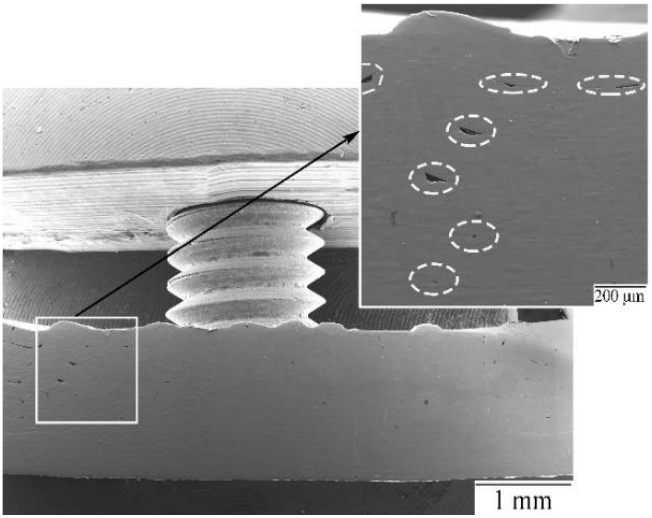
Figure 3. Macrostructure of the consolidated sample. A scaled-up image of some voids and gaps (enclosed in ellipses) is shown in the inset.